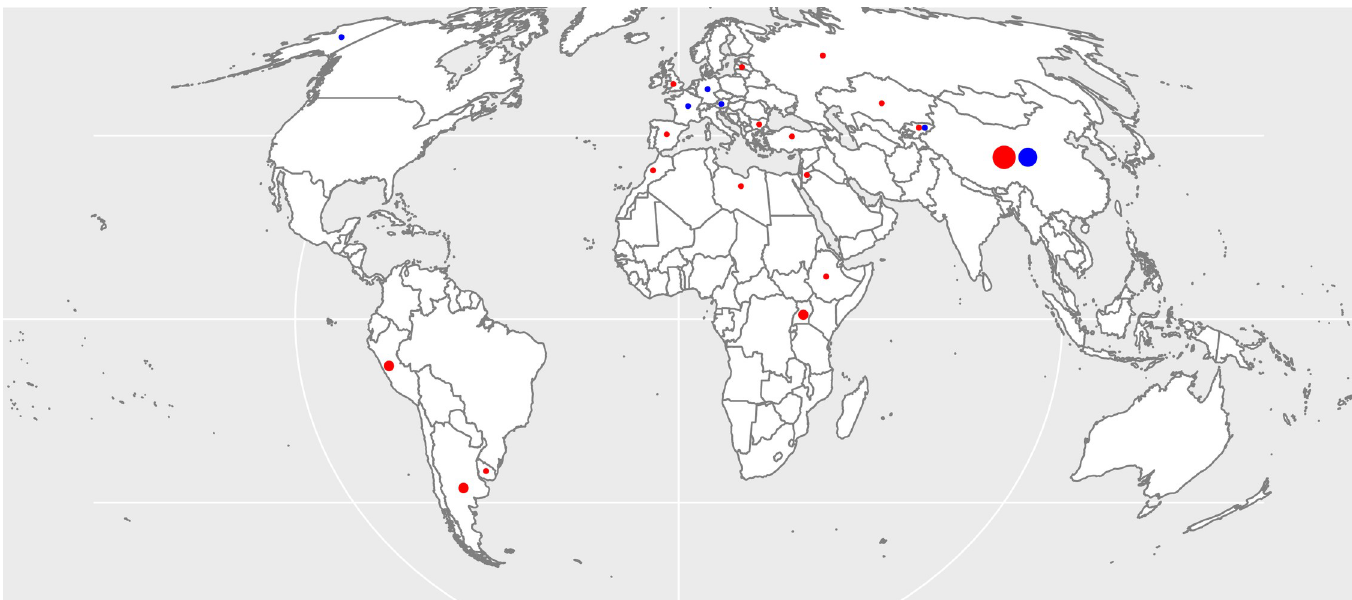
Fig 2. Geographical distribution of studies. For CE (red, size proportional to number of selected studies) this ranged from 17 studies from China, 2 from Argentina, Uganda, and Peru, and 1 for other countries. For AE (blue), there were 10 studies from China, and one each from Kyrgyzstan, Germany, Austria, France and USA (Alaska). The map was generated using the open source software R [13] using a shape file downloaded from Natural Earth